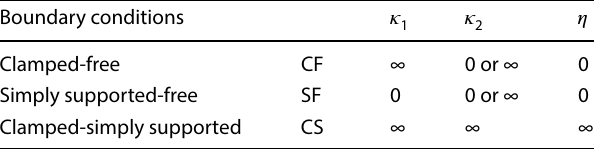
Table 1 Classical boundary condition derived from the system